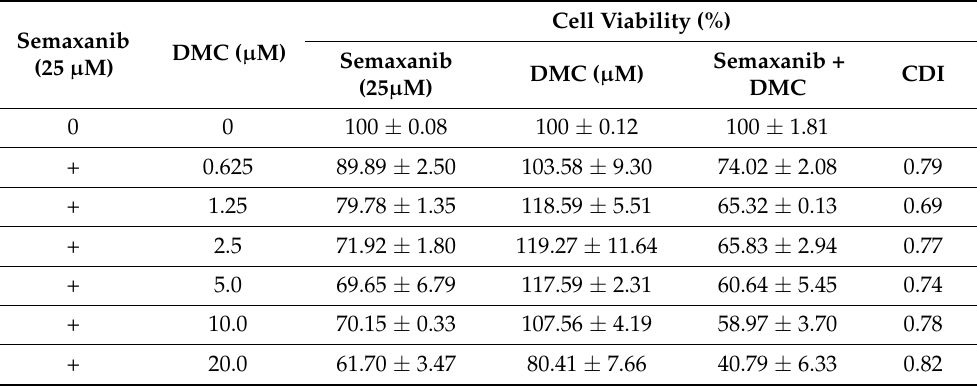
Table 2. DMC and semaxanib show synergistic effects on HUVECs cell